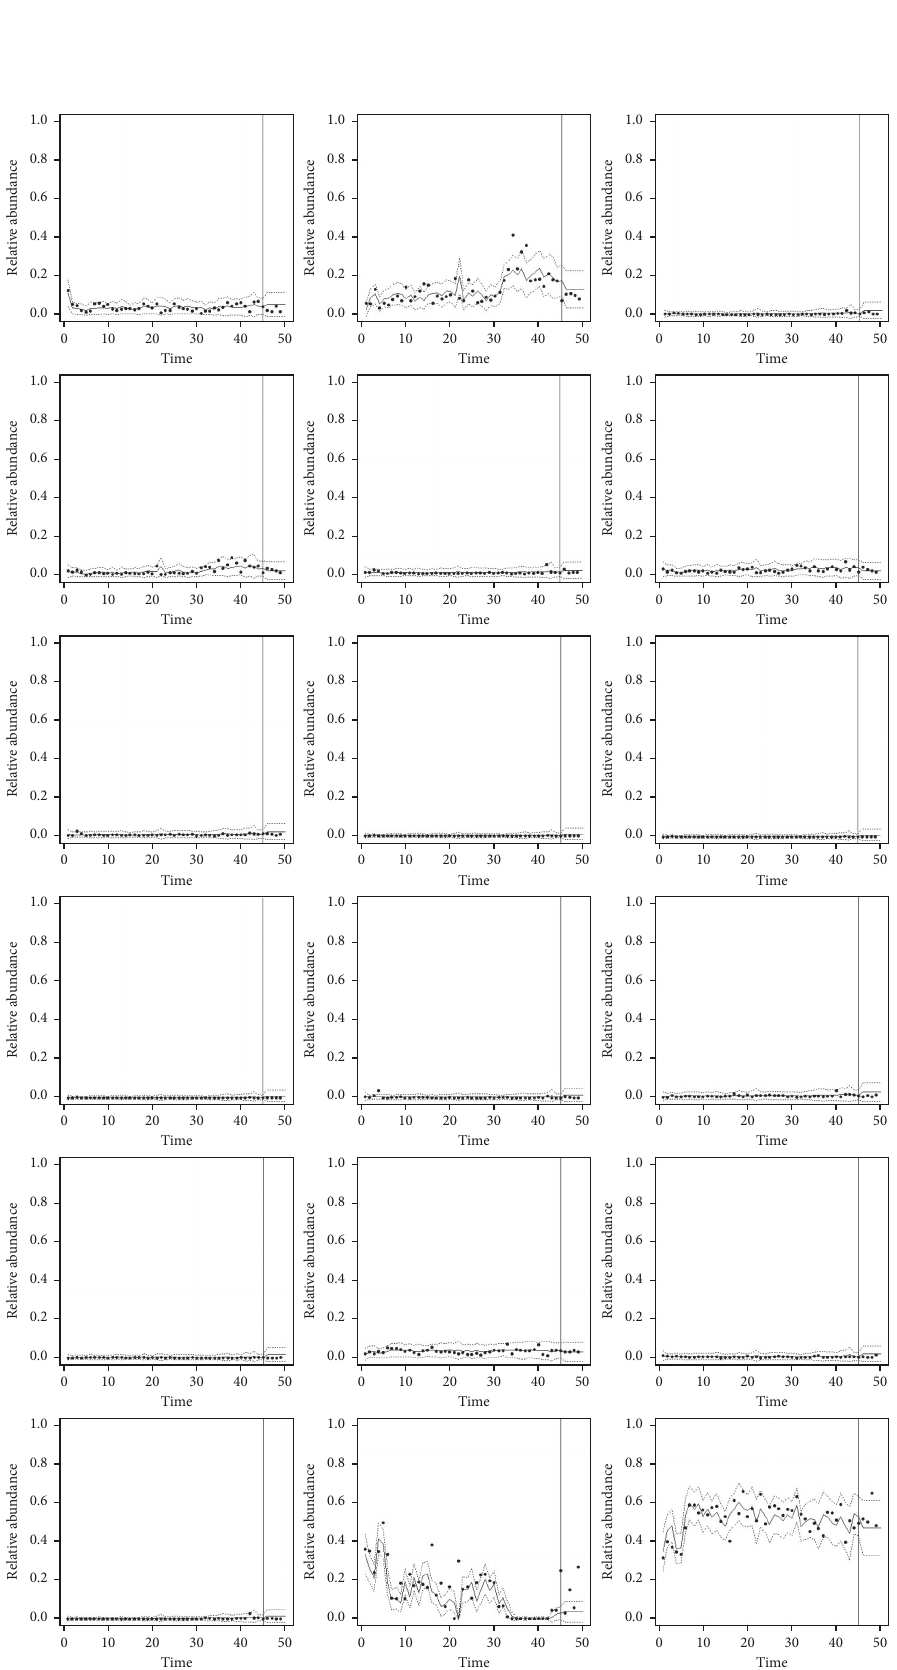
y y 2 Var . The vertical it ] it )) ( ( [ (cid:30)(cid:30)(cid:30)(cid:30)(cid:30)(cid:30)(cid:30)(cid:30)(cid:30) (cid:29) ±